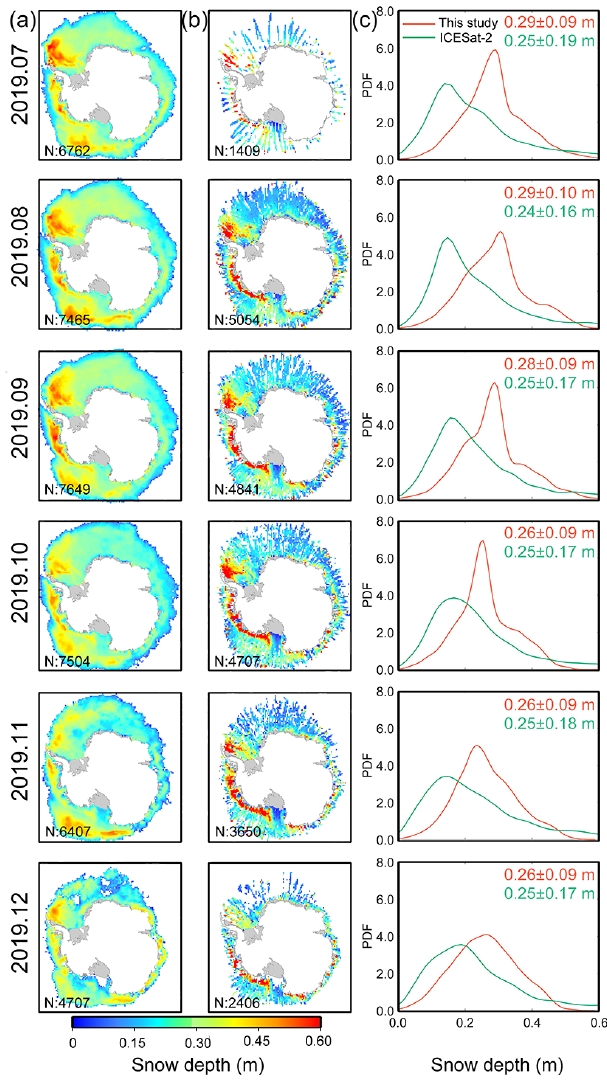
Figure 7. The spatial distributions of monthly snow depth estimates (July to December 2019) from this study (a) and ICESat-2 (b) to- gether with the number ( N ) of valid grid cells in the bottom left corner of each image. (c) The probability density functions (PDFs) from (a) (red) and (b) (green). Numerical values in the top right corner of (c) show the mean and standard deviation of the monthly snow depth estimates from (a) (red) and (b)